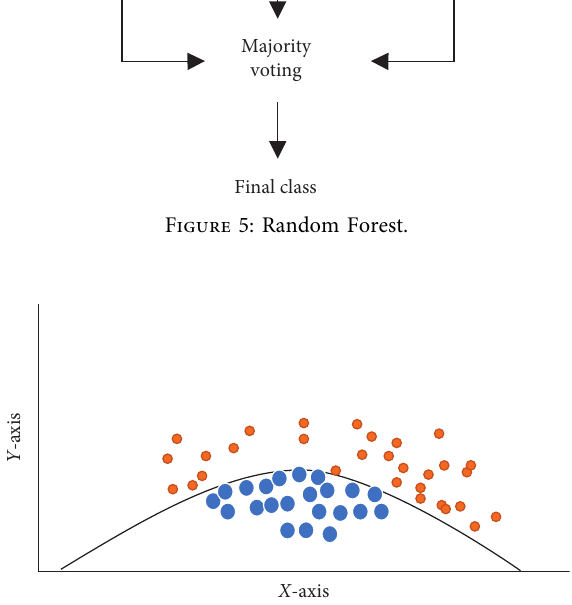
Figure 6: Na¨ıve